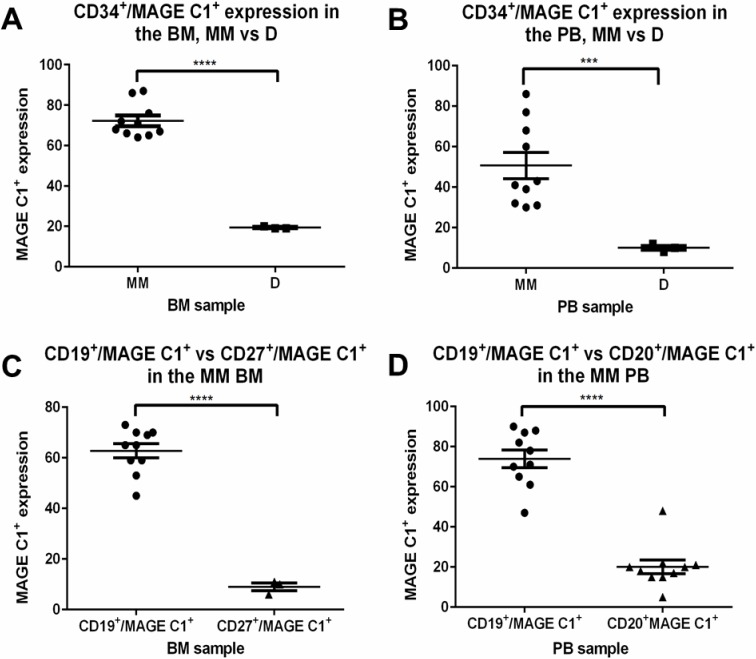
Statistical analysis of MAGE C1 expression in various B cell sub populations.An unpaired 2-tailed Student t-test was used to determine statistical significance between the different cell populations expressing MAGE C1 as indicated, with p-values <0.05 considered to be statistically significant. A: Comparison of the CD34+/MAGE C1+ cell population size found in the BM between the MM and donor groups. B: Comparison of the CD34+/MAGE C1+ cell population size found in the PB between the MM and donor groups. C: Comparison of the CD19+/MAGE C1+ and CD27+/MAGE C1+ cell population sizes in the BM of the MM group. D: Comparison of the CD19+/MAGE C1+ and CD20+/MAGE C1+ cell population sizes in the PB of the MM group. *** = 0.0001 <p< 0.001. **** = p-value <0.0001.